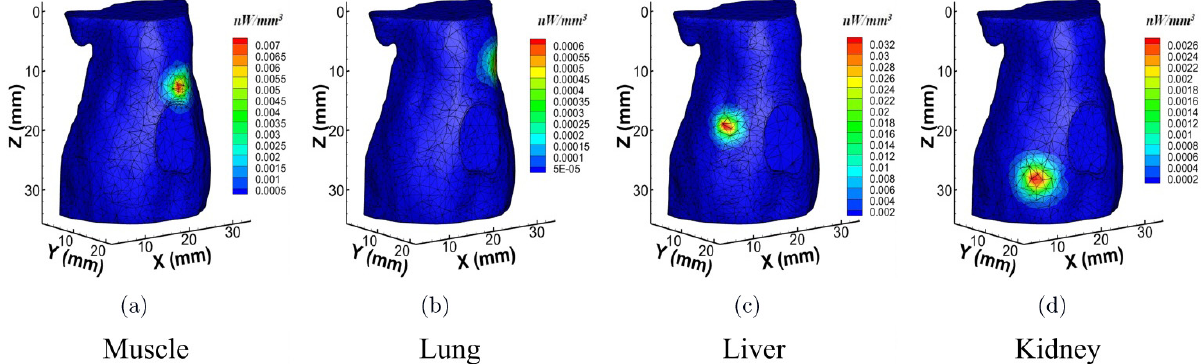
Fig. 4. Simulated photon distribution on the surface for single-source located in di®erent tissues.